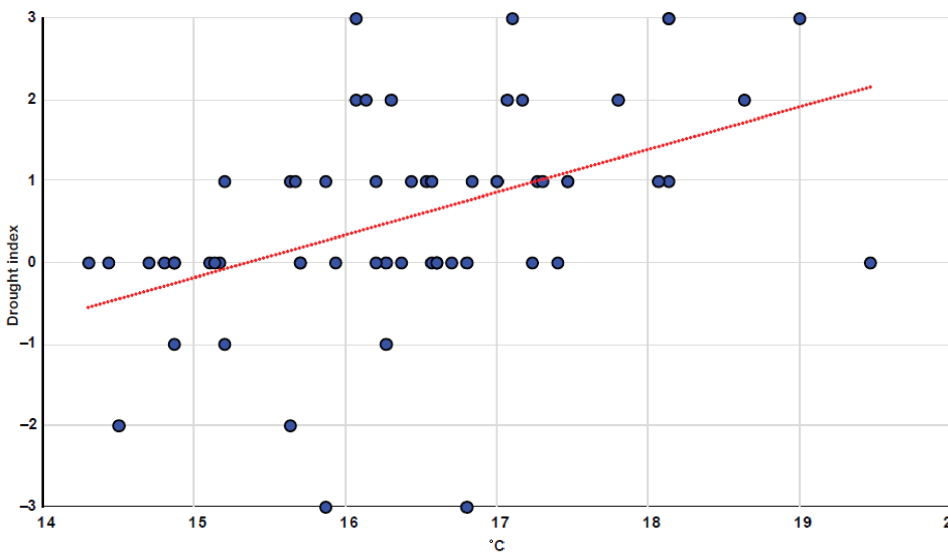
Figure 2. Scatterplot of JJA temperature for 1756–1816CE and the drought index for Sweden. Note that “very dry” is + 3, which should correspond to low levels of precipitation.